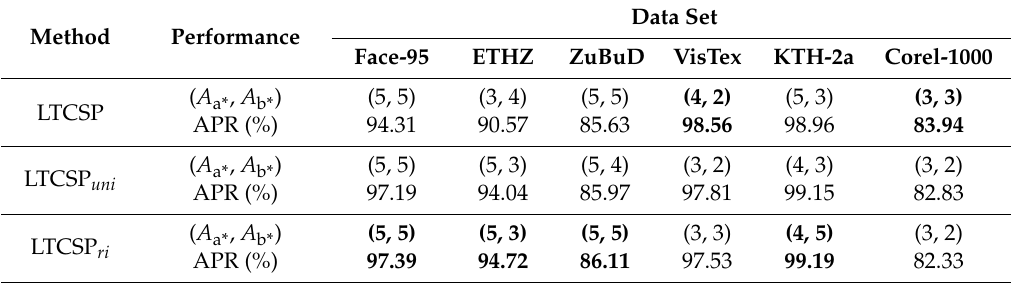
Table 2. The best APR (%) values of LTCSP, LTCSP uni and LTCSP ri with the optimal levels ( A a* , A b* ) over six datasets.